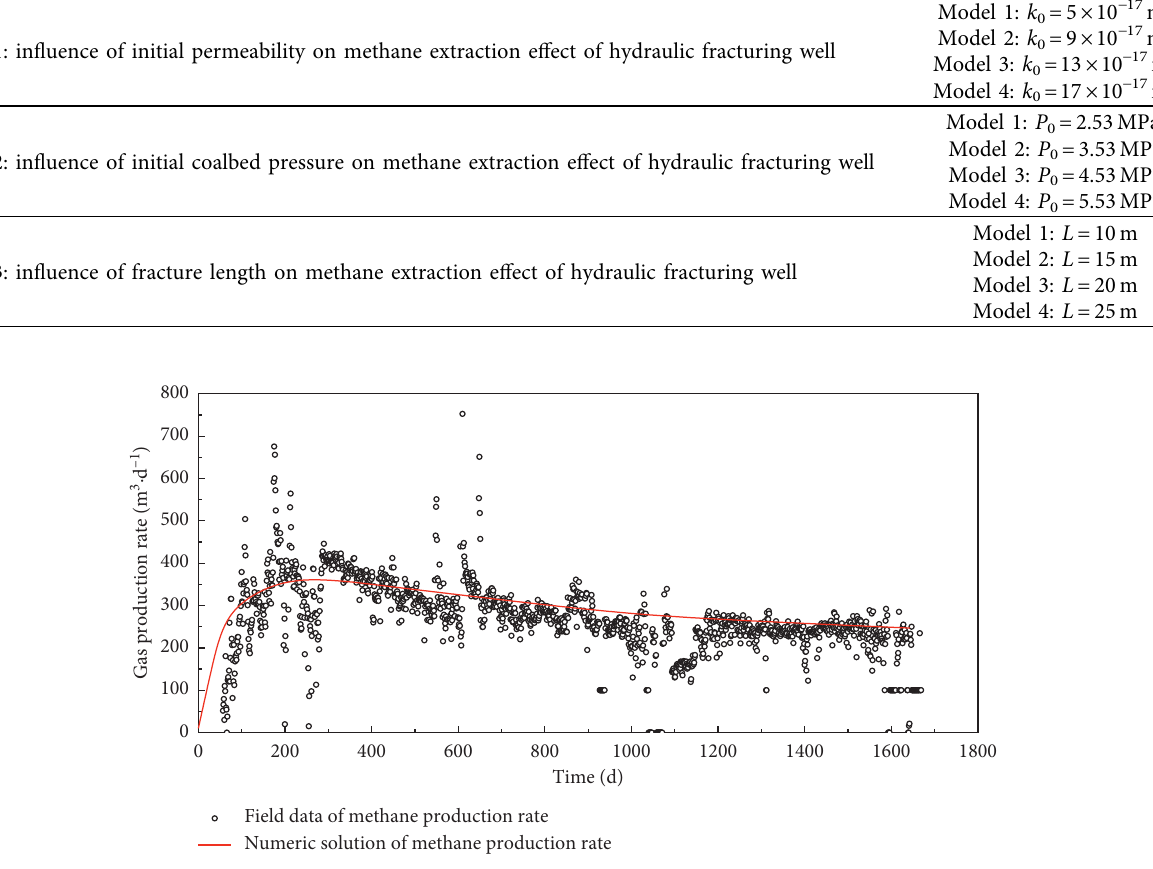
Figure 3: Comparison of numeric solution of methane production rate and field data of methane production rate.